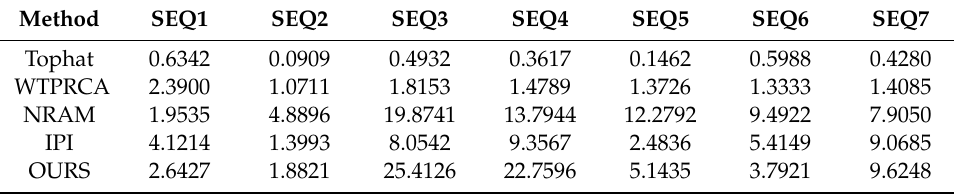
Table 4. Background suppression factor (BSF) values of representative sequences.